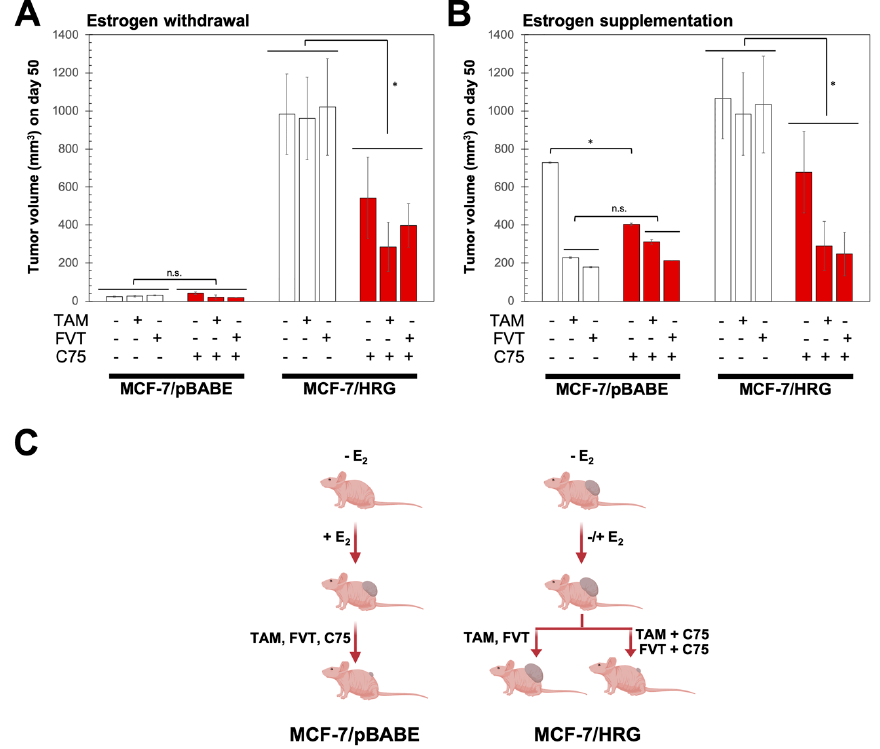
Figure 4. FASN inhibition restores anti-tumor activity of tamoxifen and fulvestrant against